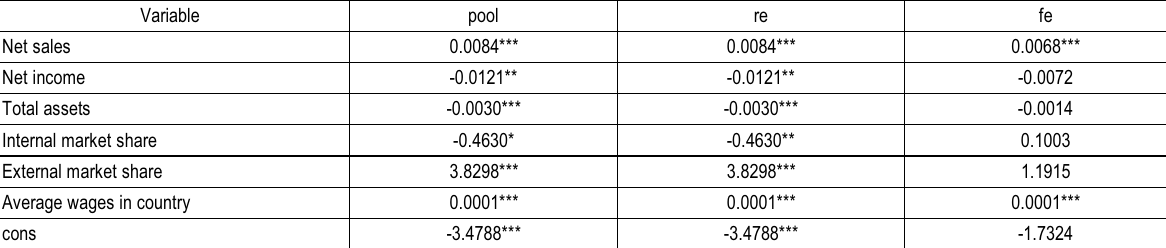
Table 2. Regression